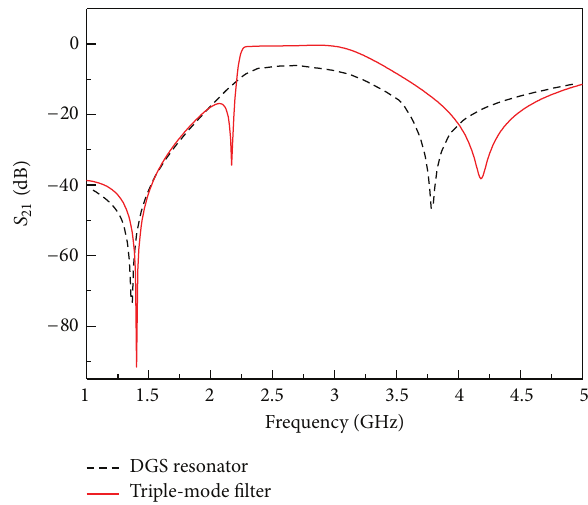
Figure 3: Synthesized theory result of triple-mode BPF.